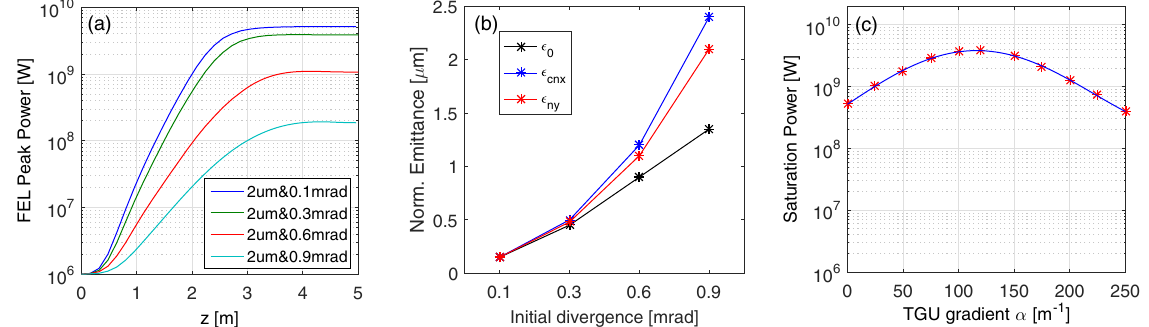
FIG. 9. (a) Seeded FEL power growth for the LPA beam with different initial divergence (emittance). (b) Normalized sliced emittance growth versus initial divergence. The slice is at the longitudinal position of the current peak. (c) Saturation power of seeded FEL as a function of TGU gradient for the tracked beam with a fixed dispersion of 21